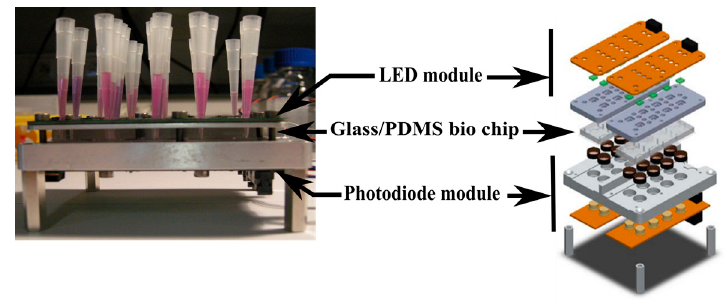
Figure 3. Fluorescence readout setup [8].